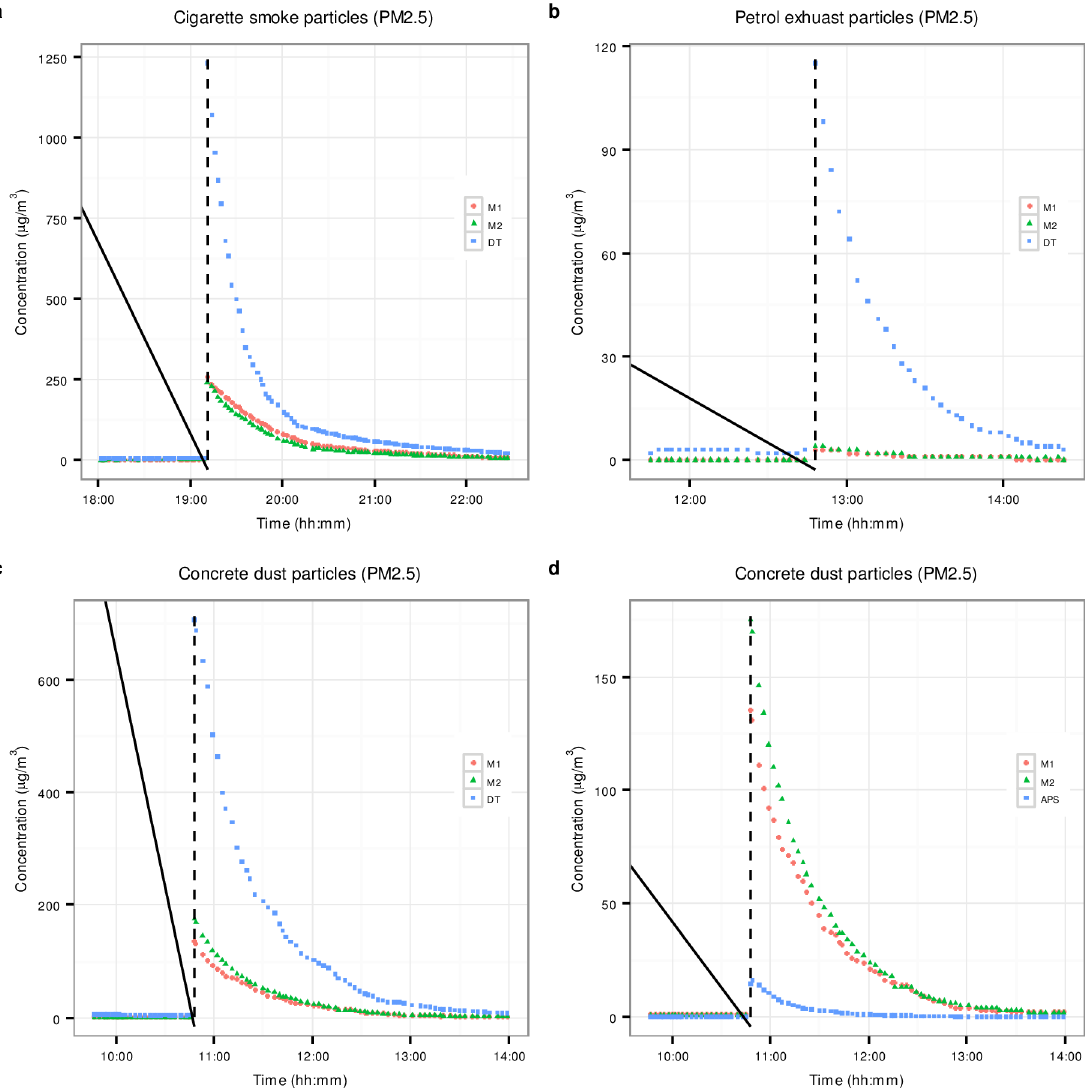
Fig 5. Time series of PM 2.5 concentrations measured during chamber experiments. a) Cigarette smoke particles measured by M1, M2 and DustTrak. b) Petrol exhaust particles measured by M1, M2 and DustTrak. c) Concrete dust particles measured by M1, M2 and DustTrak. d) Concrete dust particles measured by M1, M2 and APS. The black dotted vertical lines indicate the times at which the particles were introduced into the